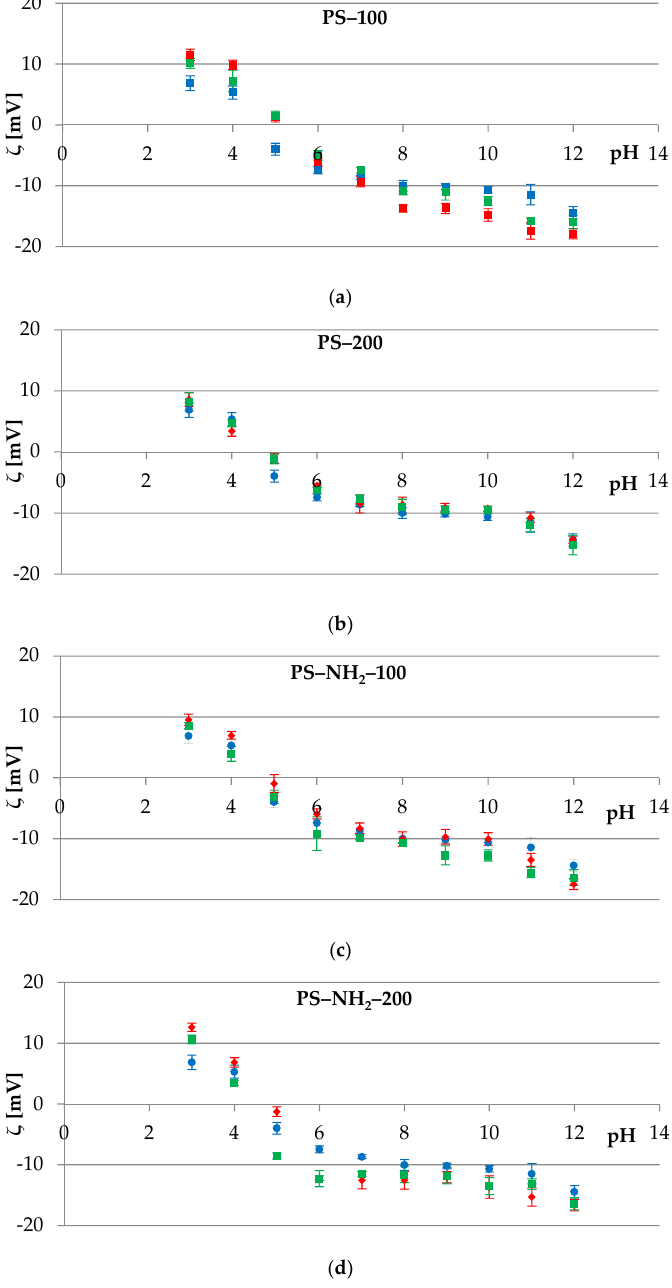
Figure 6. Zeta potential of the platelets’ cell membranes as a function of the pH of the electrolyte solution. The parameter was measured immediately ( • ), after 1 h ( (cid:7) ), and 3 h ( (cid:4) ) of exposing the sample to the polymer: ( a ) PS–100, ( b ) PS–200, ( c ) PS–NH 2 –100, and ( d ) PS–NH 2